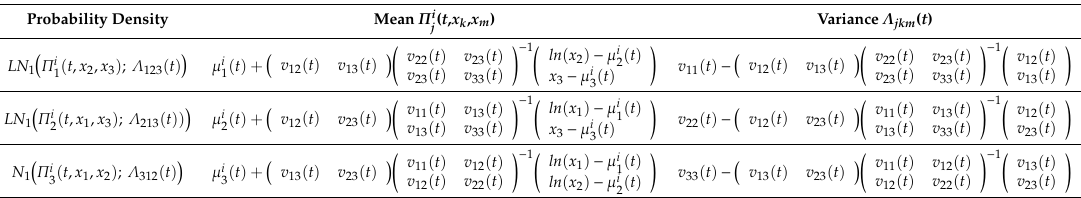
Table 4. Mean and variance of conditional probability density functions with two predictors.